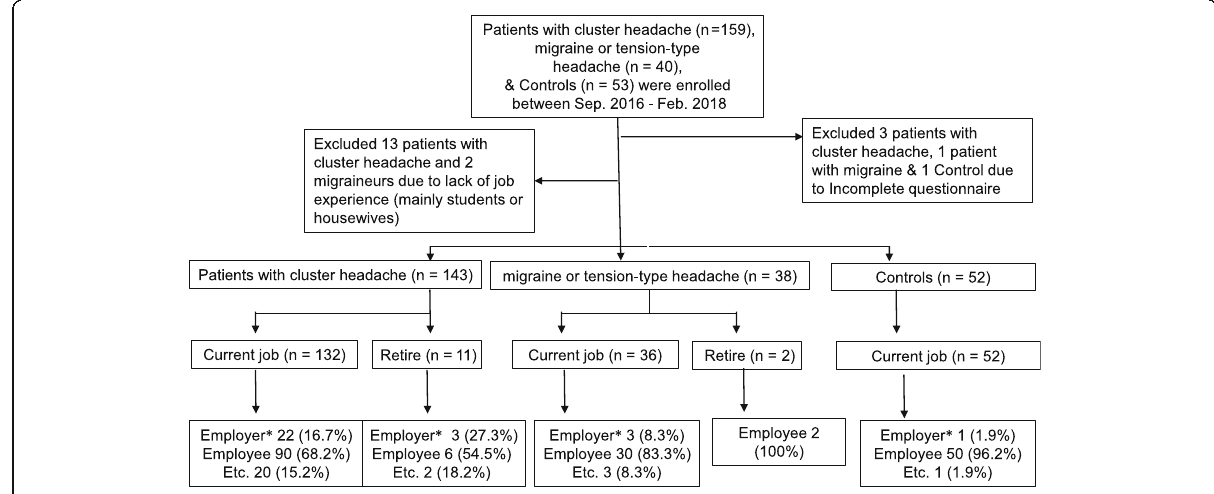
Fig. 1 Flow chart depicting the participation of subjects. *Employer included